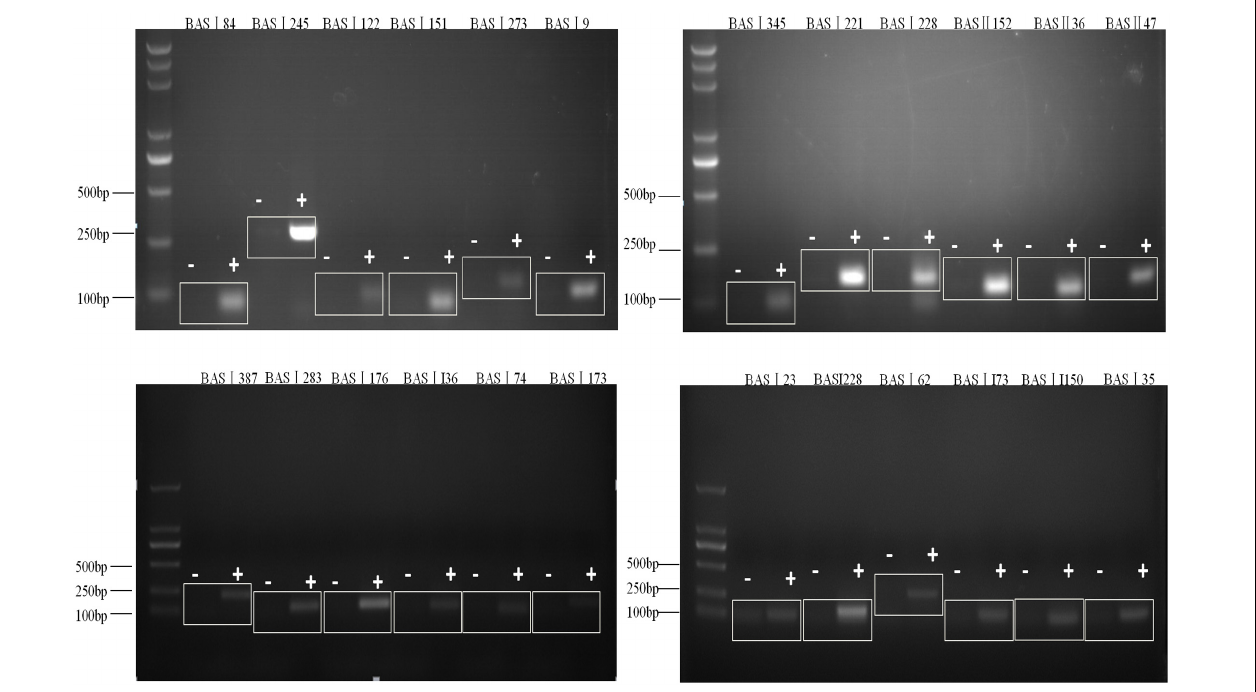
FIGURE 1 | Verification of sRNAs in B. abortus 2308. RT-PCR verification of the transcriptional unit of sRNA candidates. RNA prepared from B. abortus 2308 grown to stationary phase at 37 ◦ C was used for RT-PCR. The regions to be amplified were shown by bars with numbers. “+” represents reactions with reverse transcriptase and “-” represents reactions without reverse